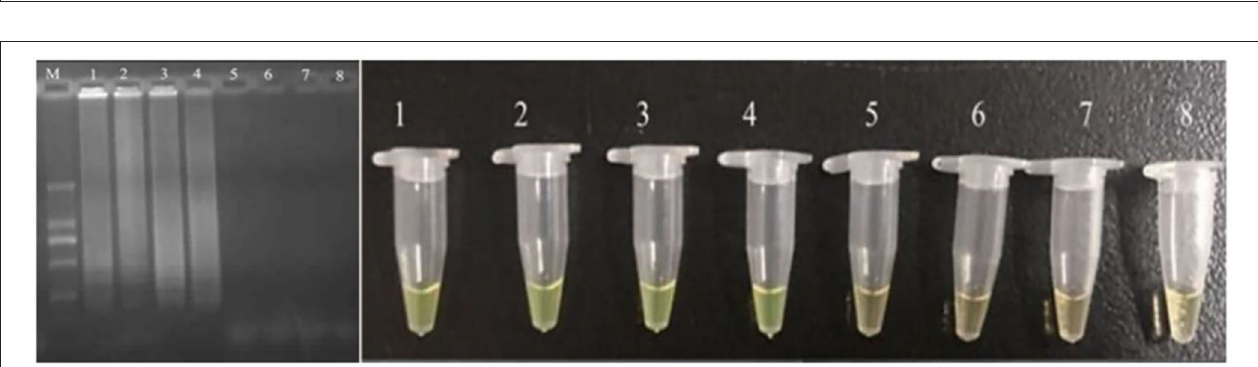
FIGURE 3 | Sensitivity for pheS in artificially contaminated food samples. M-DNA marker; 1–7 refer to 10 7 , 10 6 , 10 5 , 10 4 , 10 3 , 10 2 , and 10 cells/ml; 8 refers to negative